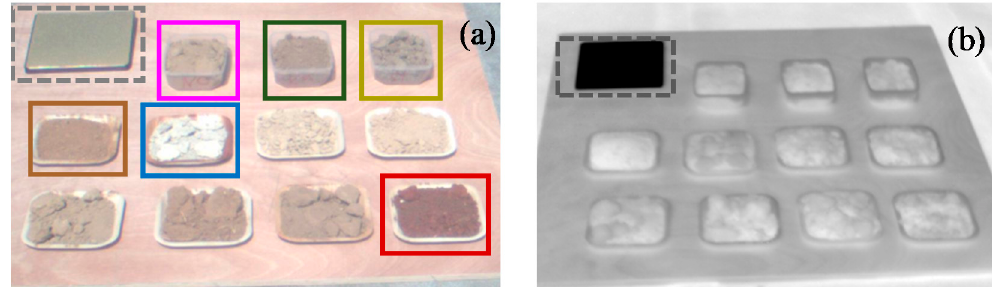
Figure 1. Red-green-blue (RGB) image ( a ) and longwave infrared (LWIR) image (band 10.62 µm) ( b ) of soil samples (each placed on a 0.04 m 2 plate) and a gold plate (gray dashed square), measuring the downwelling radiance (used to calculate the emissivity spectrum of each soil sample, as described in [9]); emissivity spectra of selected soil samples (colored squares) are shown in the next section (with respective colors).